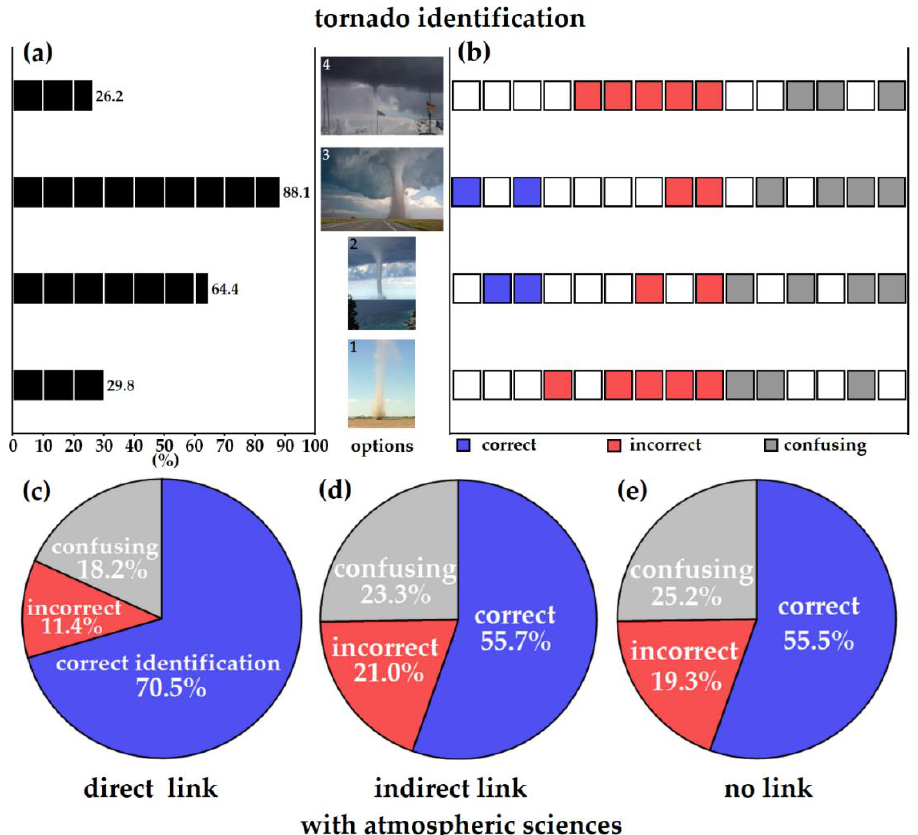
Figure 5. The initial results of the multiple choice question Q1 for testing the ability of respondents to identify tornadoes ( a ), the filter for discerning correct (full blue squares), incorrect (full red squares) and confusing (full grey squares) choices; each column of four squares represents a choices type identified within the survey; full white squares represent those options not taken into consideration by the respondents for each series of four options within the columns ( b ), and the final results after applying the filter to the three sub-sets containing the responses from people with professions directly ( c ), indirectly ( d ) and not ( e ) linked with the atmospheric sciences.